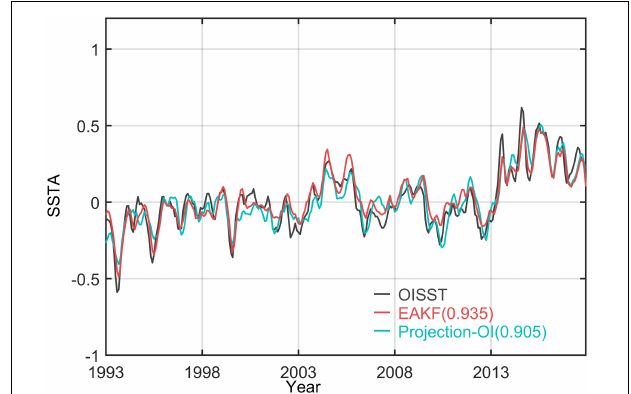
FIGURE 1 | Time series of area-averaged SSTAs (units: ◦ C) over the North Pacific (20–70 ◦ N, 110 ◦ E–100 ◦ W) with respect to climatology for 1993–2017. Three-month-running smoothing is applied. The black line represents SSTAs from OISST v2 observation; red and blue lines represent EAKF and Projection-OI assimilation results, respectively. The values in brackets are correlation coefficients between assimilation results and observation.